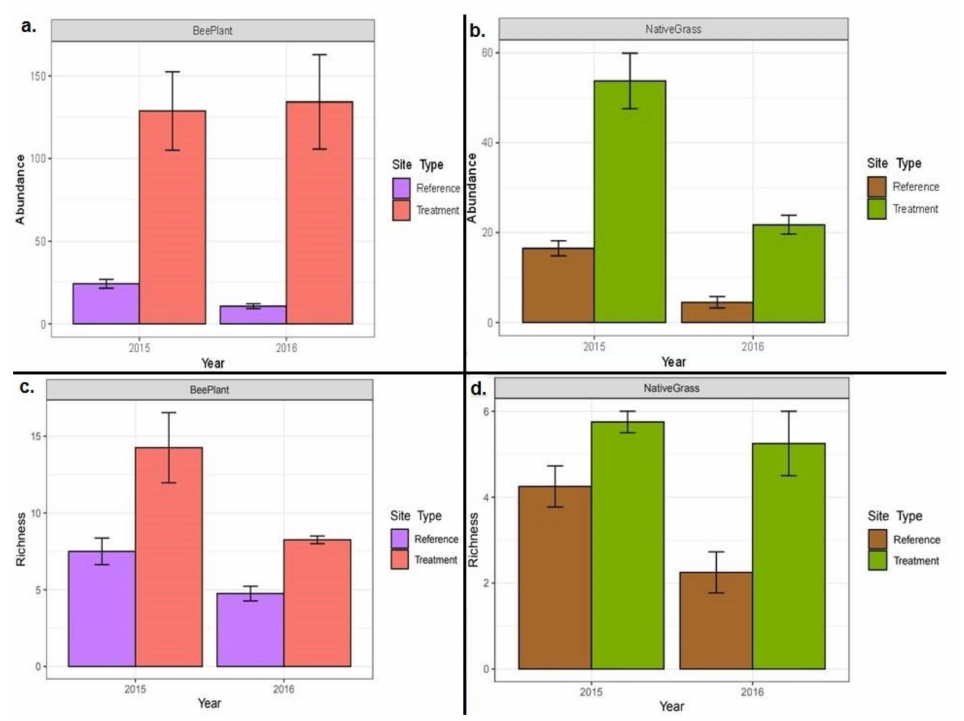
Figure 3. Bar plot showing mean insect abundance ( a , b ) and richness ( c , d ) on reclaimed well pads that were predominantly Rocky Mountain bee plant or native grass, compared to their reference sites. Error bars are standard error. Note, the range of values on the y -axis varies among each plot.